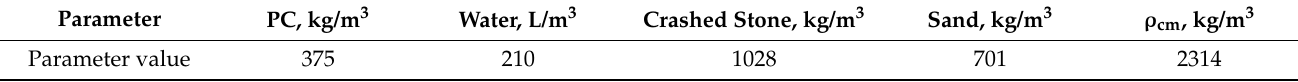
Table 3. Dosages of concrete mix